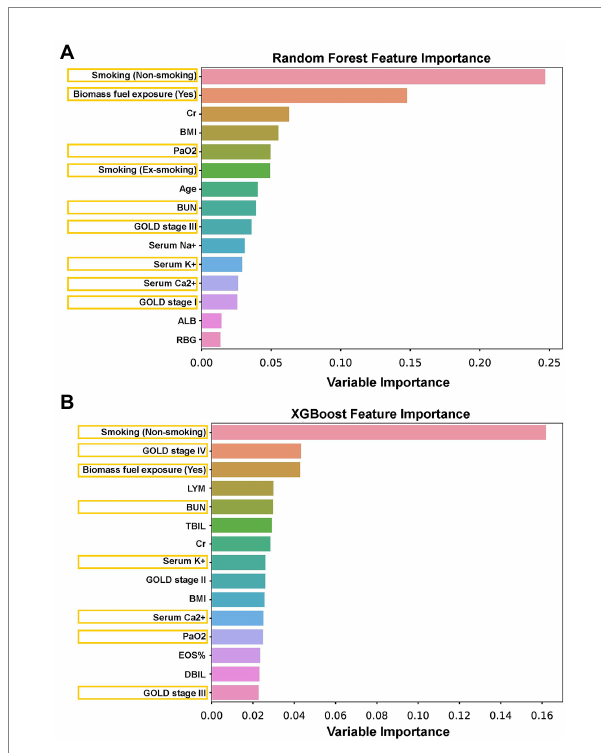
FIGURE 4 The sex-associated important variables were explored by random forest and XGBoost tree models. (A) The top 15 sex-associated important variables were identified by a random forest tree model. (B) The top 15 sex-associated important variables were identified by the XGBoost tree model. Orange box: The overlapped variables between the tree model and binary logistic regression.